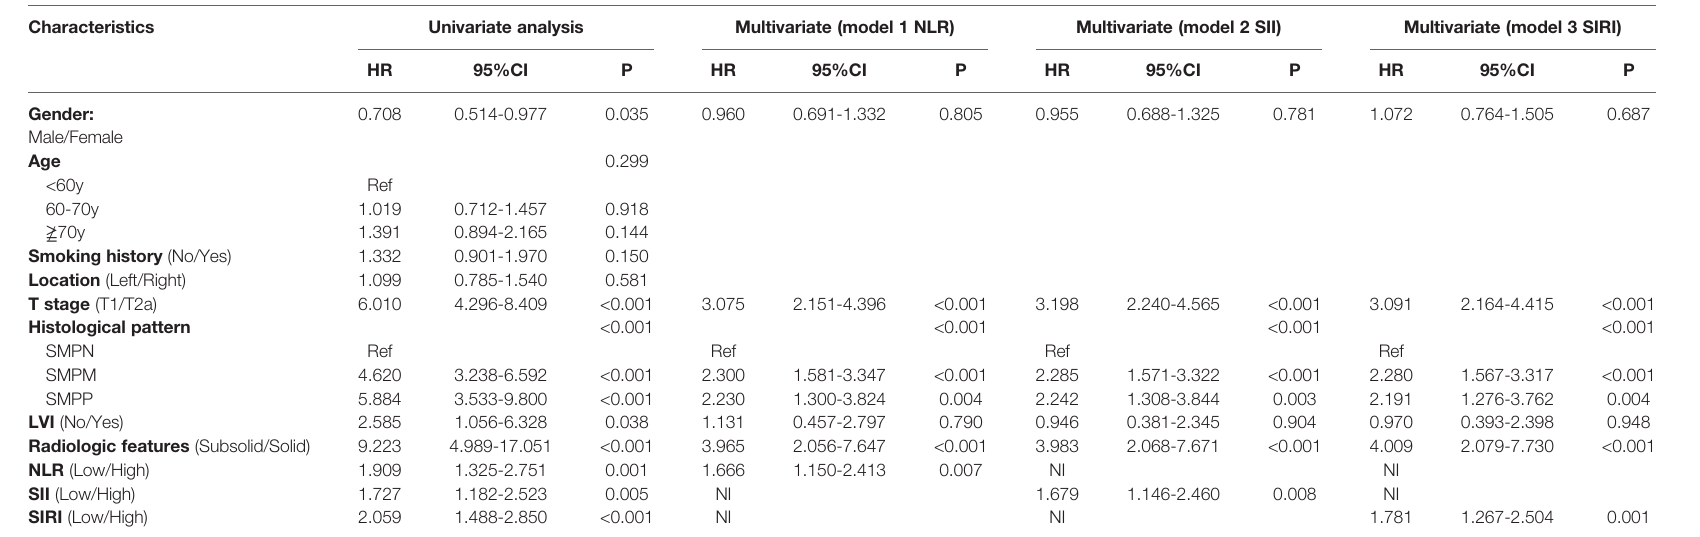
TABLE 4 | Univariate and multivariate cox regression analysis of factors associated with disease-free survival.